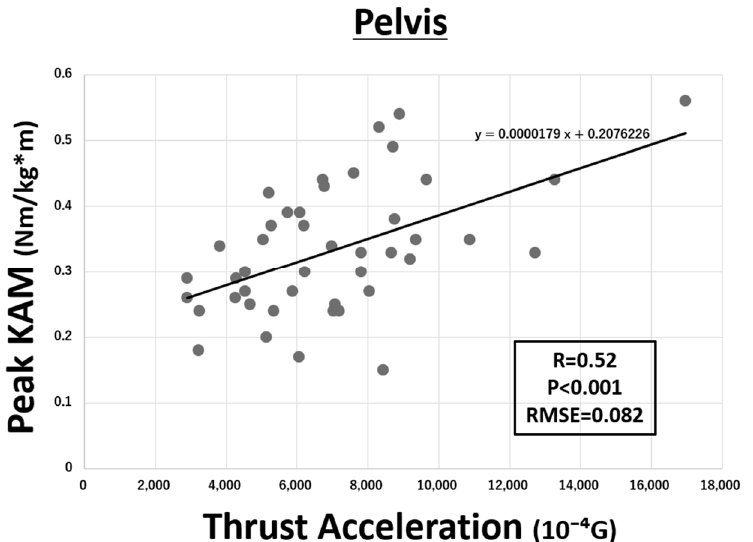
Figure 4. Correlation between the peak knee adduction moment (KAM) and thrust acceleration (TA) on the pelvis (R = 0.52, p < 0.001). The root mean square error (RMSE) was 0.082 Nm/kg*m (G = 9.81 m/s 2 ).